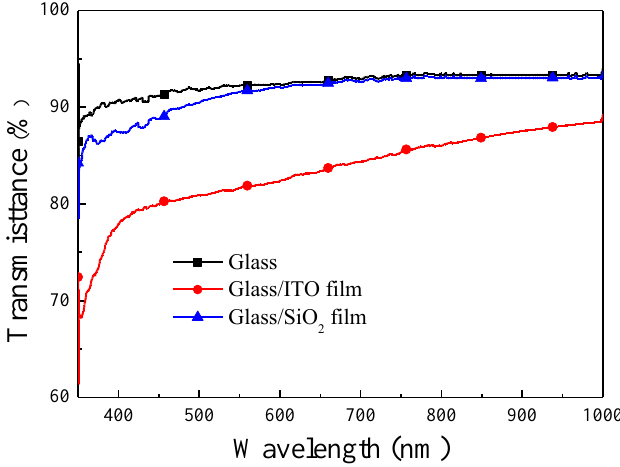
Figure 3. Optical transmittance of ITO film deposited by Radio frequency (RF) thermal sputtering.